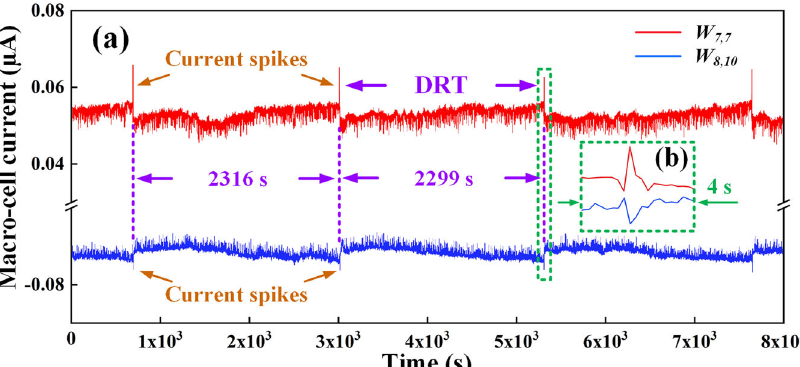
Fig. 3 The dynamic changes of macro-cell currents. a Time dependence of the macro-cell currents of W 7,7 and W 8,10 . b The instant current change after droplet